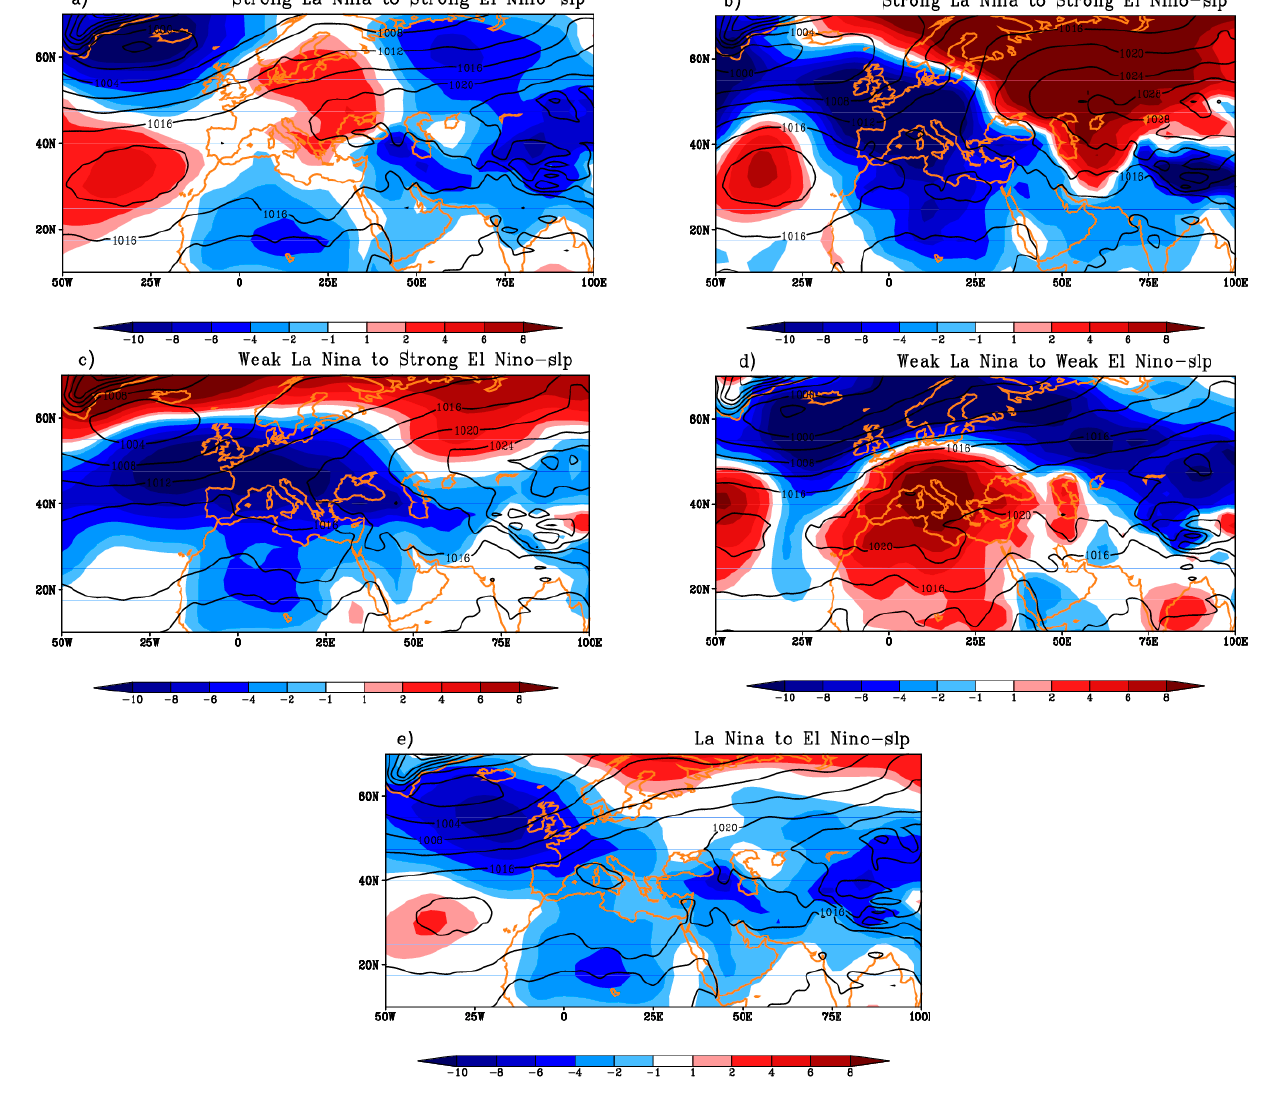
Figure 6. Same as Figure 5, but for type 2 transitions.